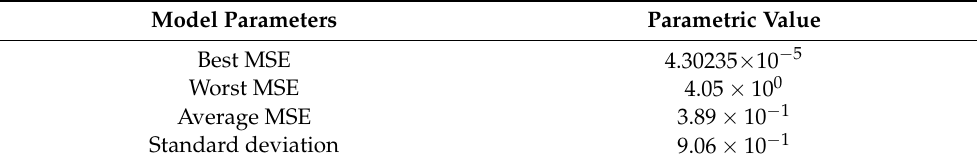
Table 7. Case Study II Parameters after Simulation.